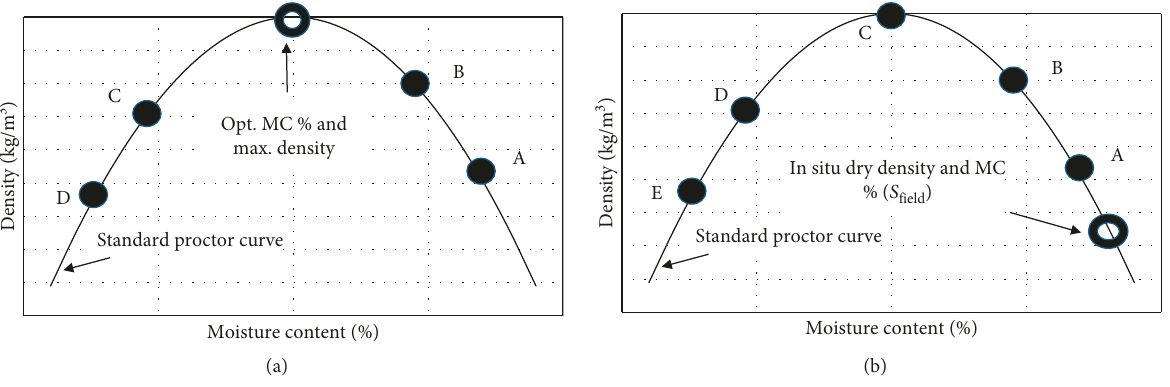
Figure 6: Moisture-density curves for (a) EICM F